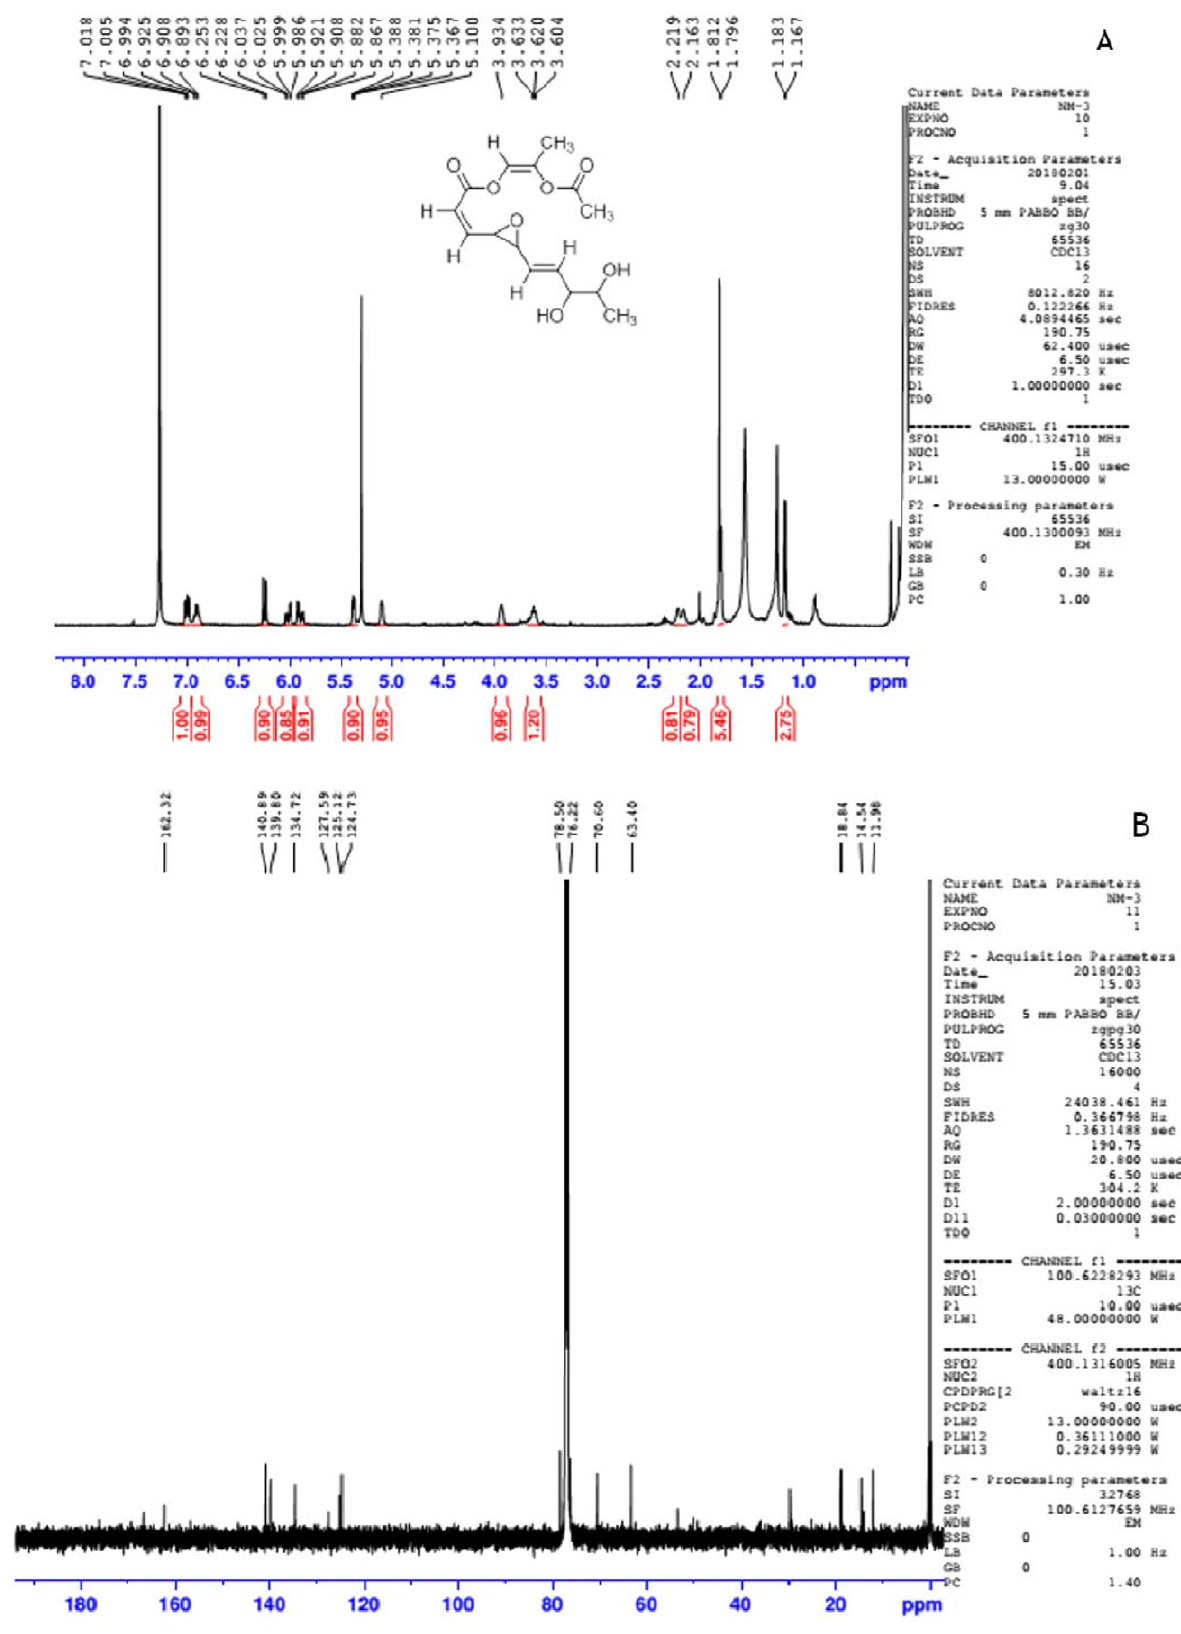
Figure 4. 1 H NMR spectra (A), 13 C NMR spectra (B) for toluene standard and compound